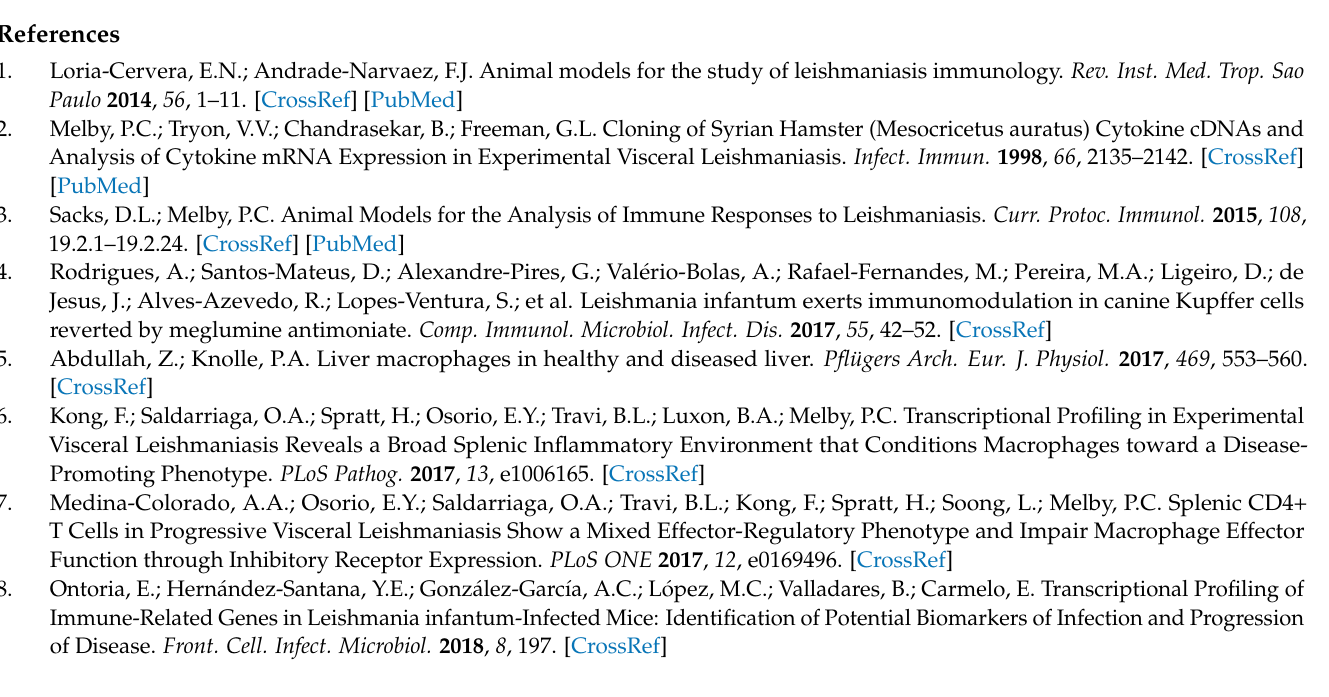
Table S1, List of TaqMan assays used for RT-qPCR analysis using Quant Studio TM 12K Flex Real-Time PCR